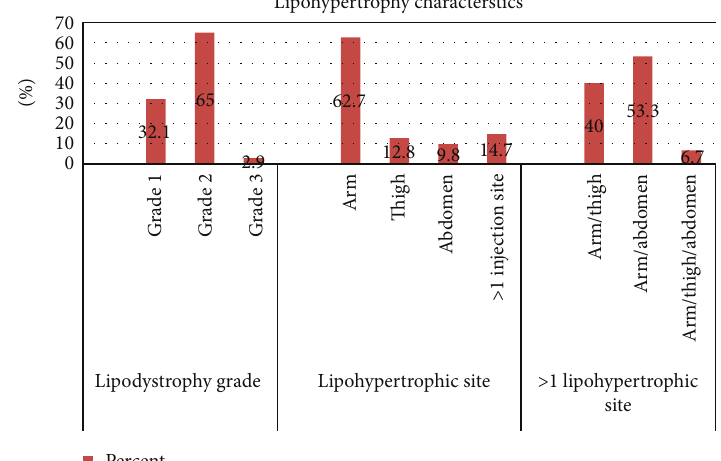
Figure 2: Characteristics of insulin-induced lipohypertrophy among patients with type 1